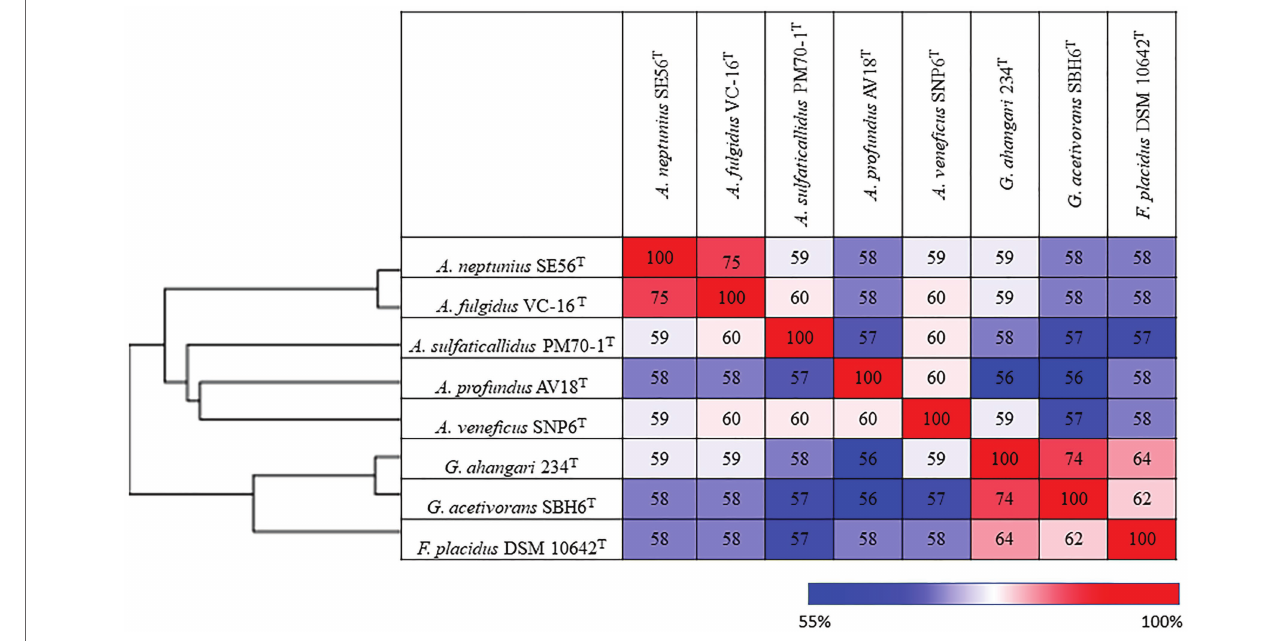
FIGURE 6 | Pairwise average amino acid identity (AAI) determined for members of the class Archaeglobi